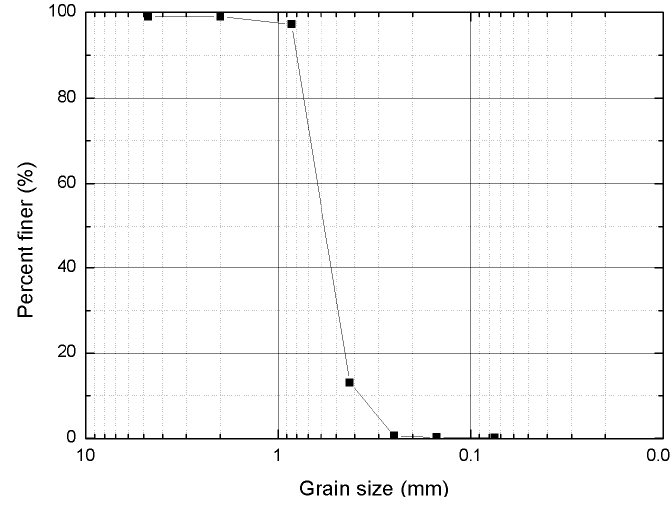
Figure 1. Grain size distribution of Jumunjin sand.